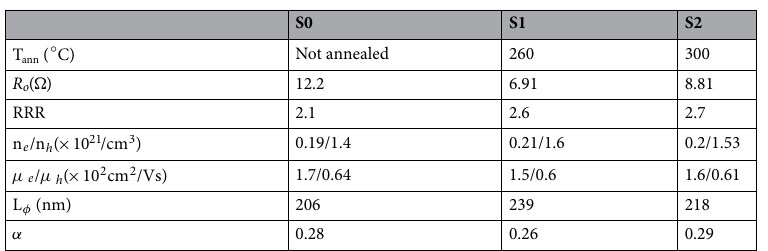
Table 1. Parameters for Pd 3 Bi 2 S 2 thin films. T ann is the post-annealing temperature, R o is the sheet resistance at the lowest temperature, RRR is the residual resistivity ratio, n e ( n h ) is the electron(hole) carrier density, µ